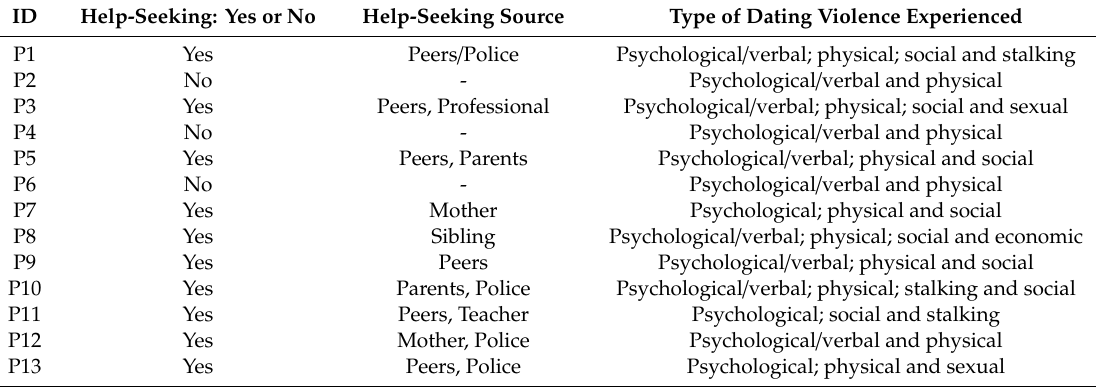
Table 2. Participants’ help-seeking behaviour and type of experienced dating violence ( n =